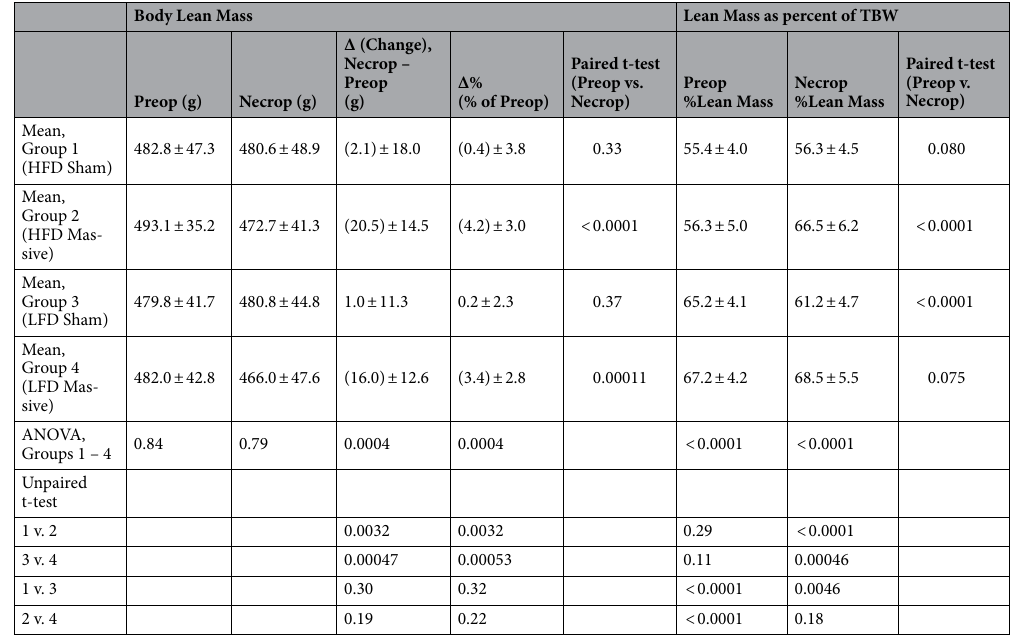
Table 7. Effect of diet and resection on lean mass. Values shown are mean ± standard deviation. Red values in parentheses (xx.x) represent a negative change (decrease). Preop = Preoperative (after dietary induction, immediately prior to resection); Necropsy = immediately prior to necropsy (two months after resection); HFD = High-Fat Diet; LFD = Low-Fat Diet; Massive = Massive 75% distal small intestinal resection; Sham = Sham resection; TBW = Total Body